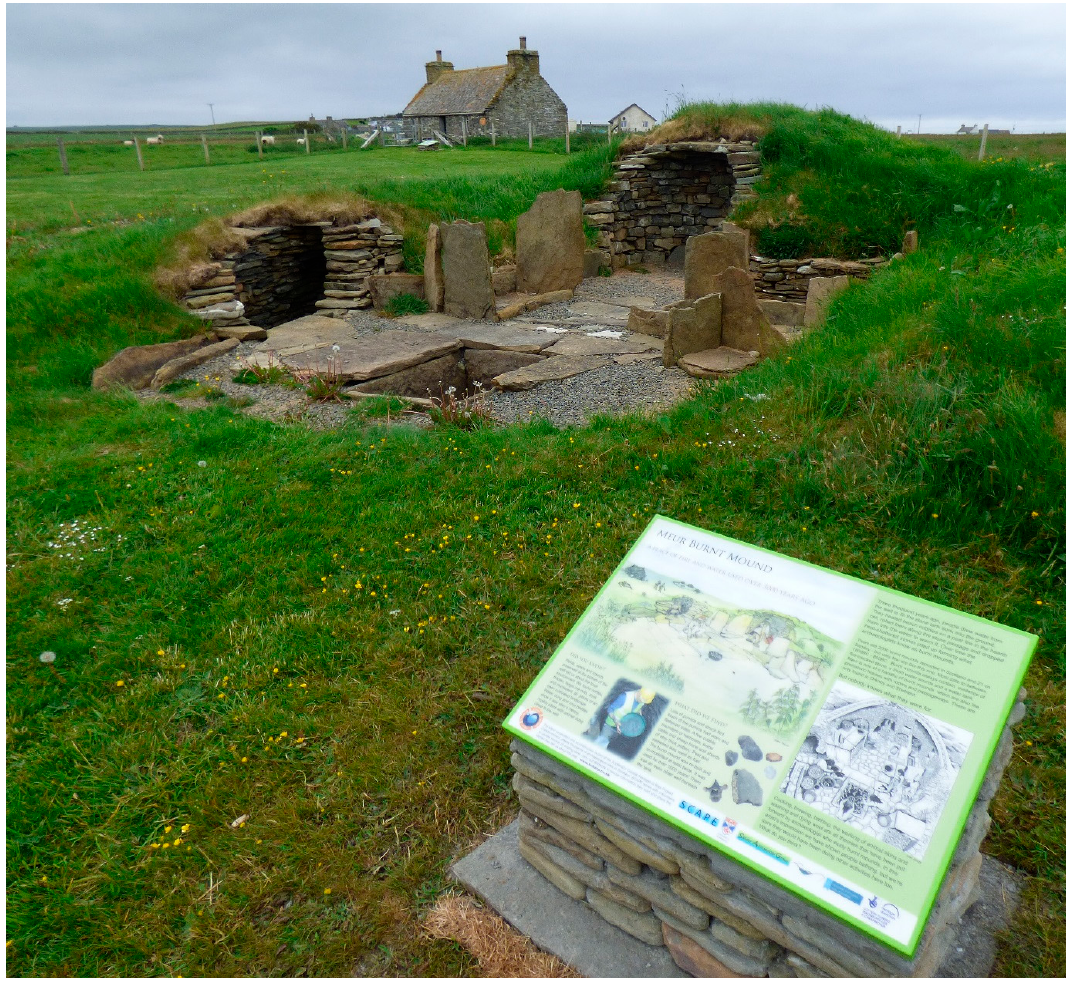
Figure 6. The reconstructed burnt mound structures and interpretation panel at the Sanday Heritage Centre.